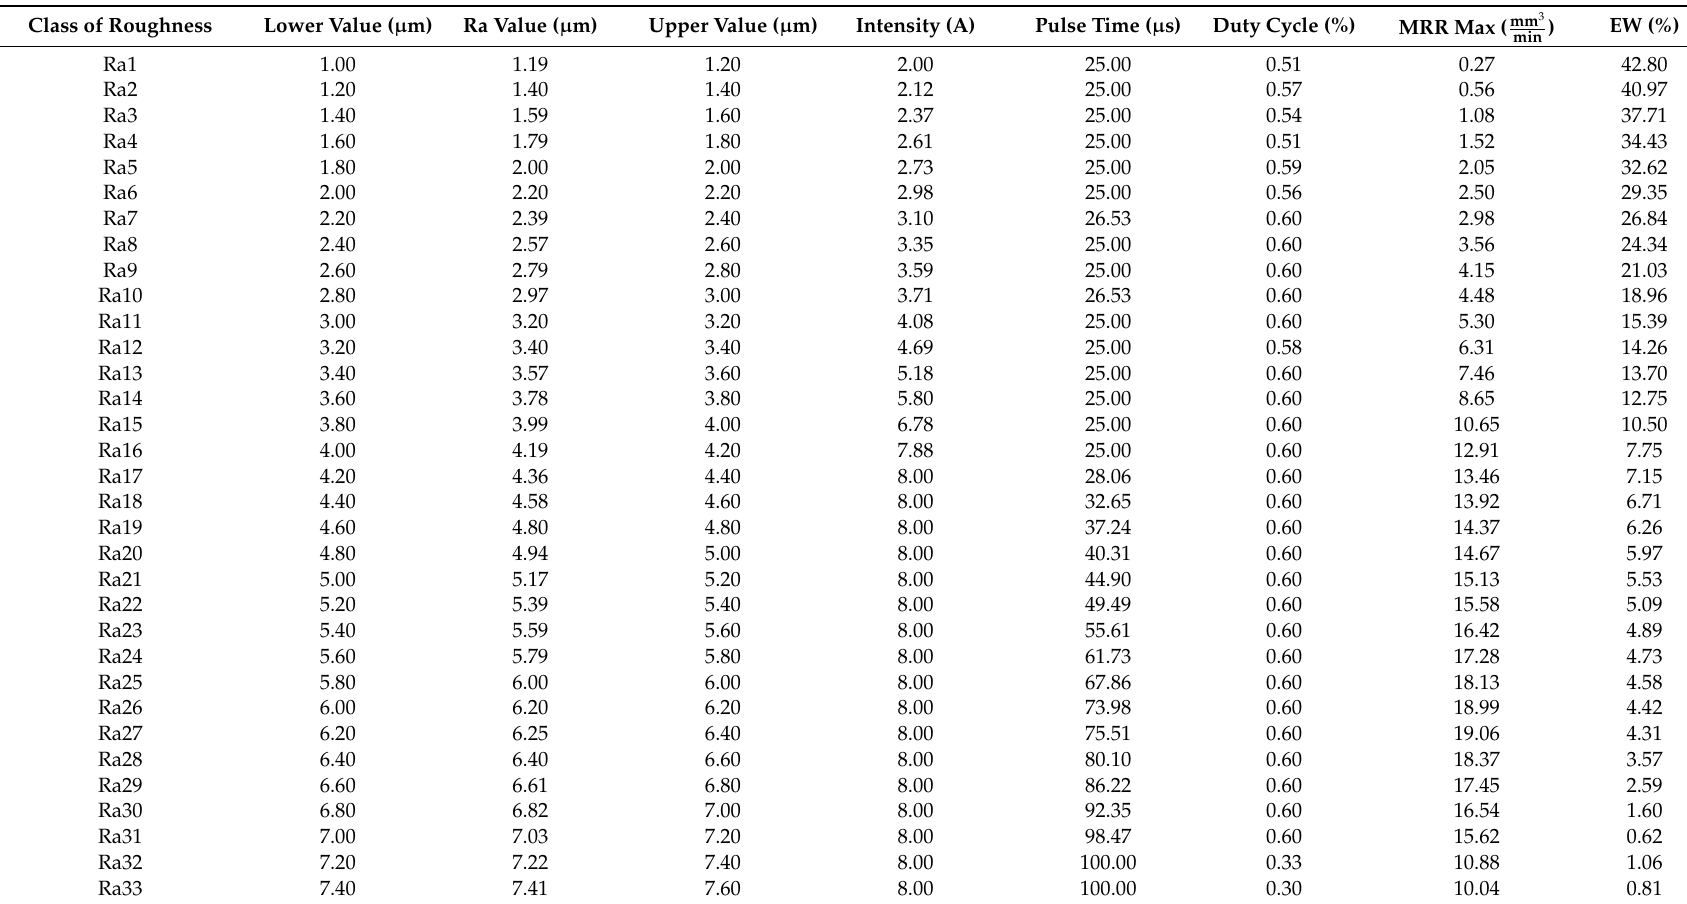
Table 5. Strategy of maximum material removal rate. Technological table obtained from the FIS, for the case of maximum removal rate strategy (positive polarity). Class of